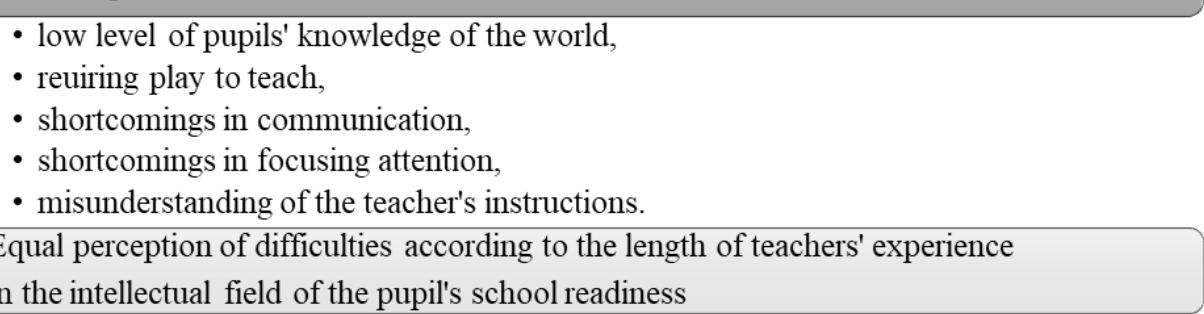
Figure 3. Perception of the causes of intellectual adaptation difficulties.